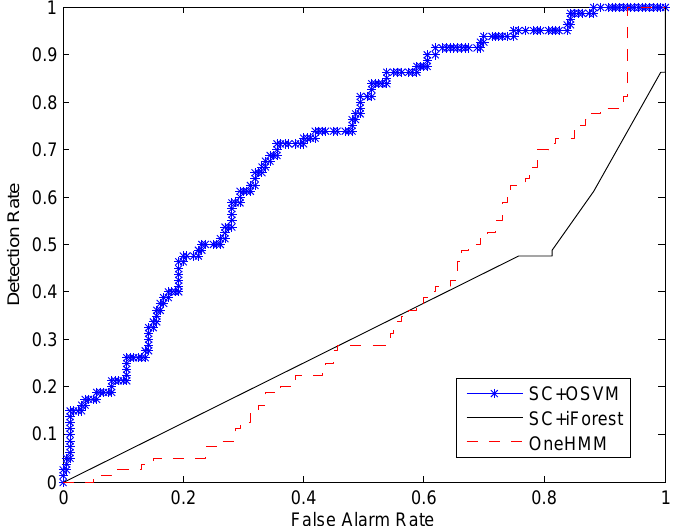
Figure 8. Comparison of the detection rate and the false alarm rate versus different numbers of training samples: training on 160 normal samples.